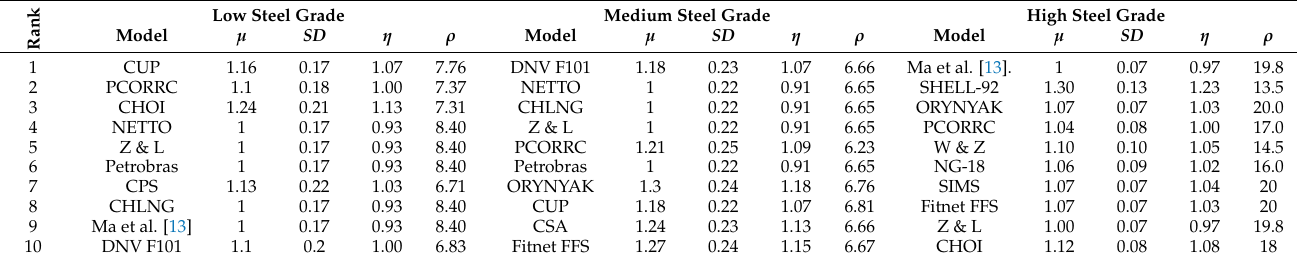
Table 1. Stochastic description of model uncertainty factor ( X m ).